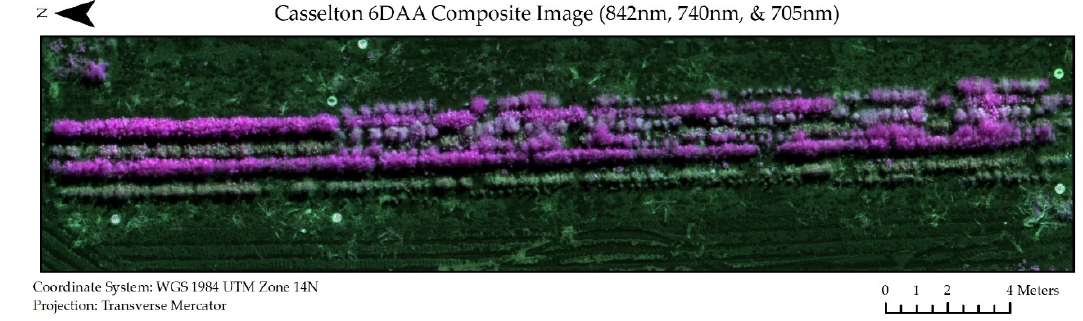
Figure 5. Image datasets from Casselton at 6 days after glyphosate application (6 DAA) used in classification models. ( a ) Shapefiles denoting species and biotype location within the scene. ( b ) Thermal image dataset. ( c ) NDVI image dataset. ( d ) Composite Image Dataset for all wavelengths of the multispectral image (RRPW: Redroot Pigweed).